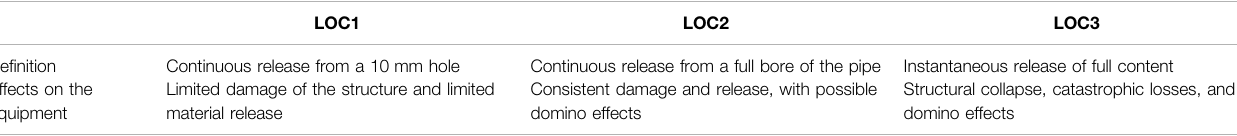
TABLE 4 | De fi nition of LOC events in process plant equipment. LOC1 LOC2 LOC3 De fi nition